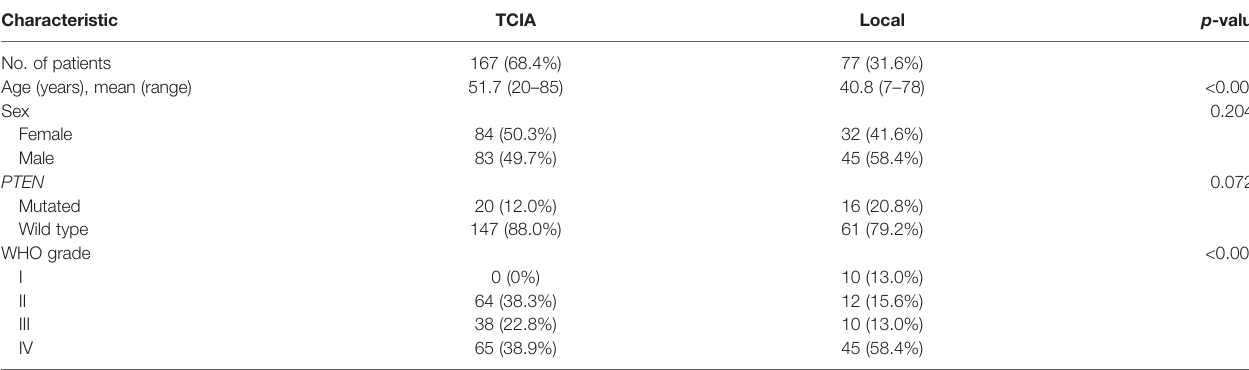
TCIA, The Cancer Imaging